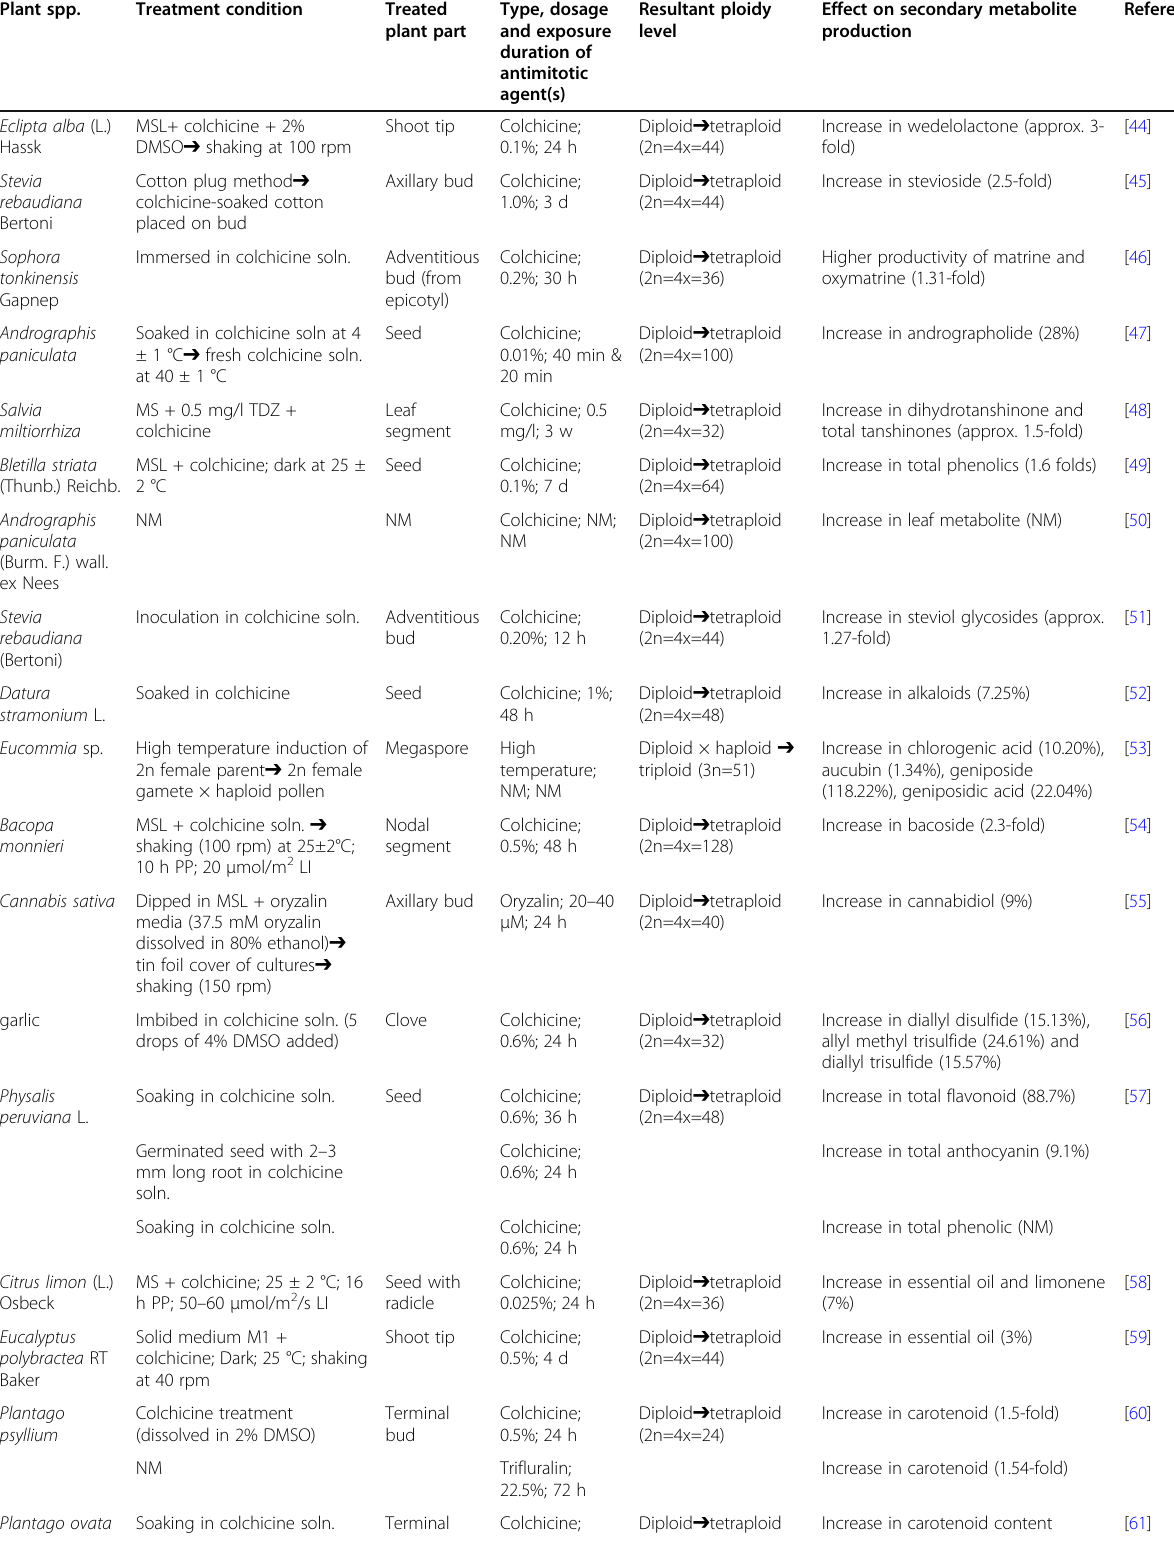
Table 1 Antimitotic agent(s) and their influence on autopolyploidization and subsequent secondary metabolites production (arranged in chronological order) (Continued) Plant